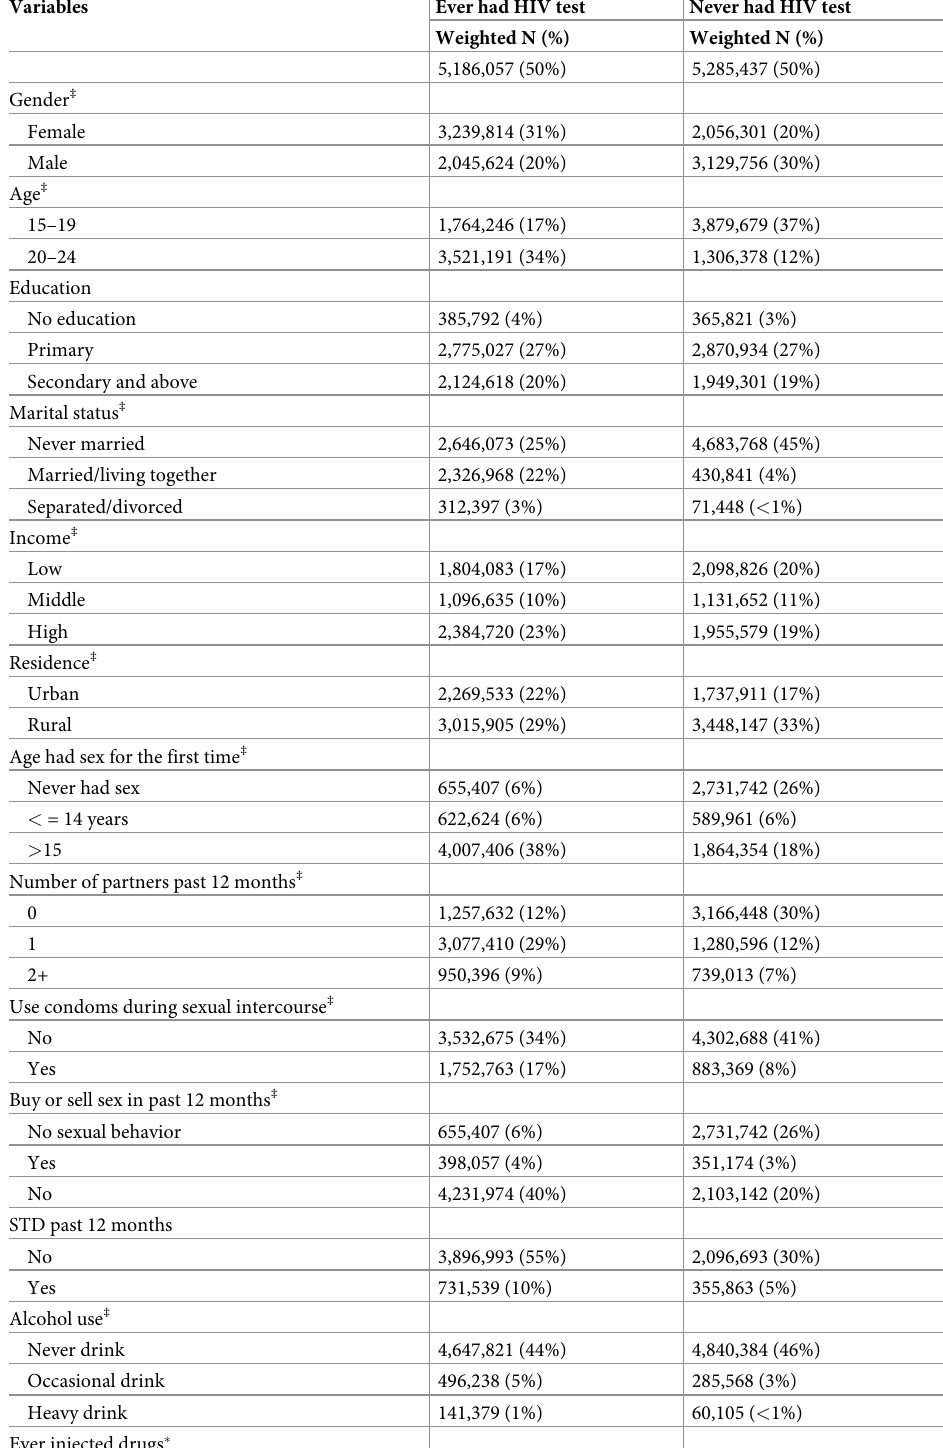
Table 2. Bivariate analysis of ever having tested for HIV among adolescent and young adults aged 15–24 in Tanza- nia by demographic and socio-behavioral characteristics (N = 10.5